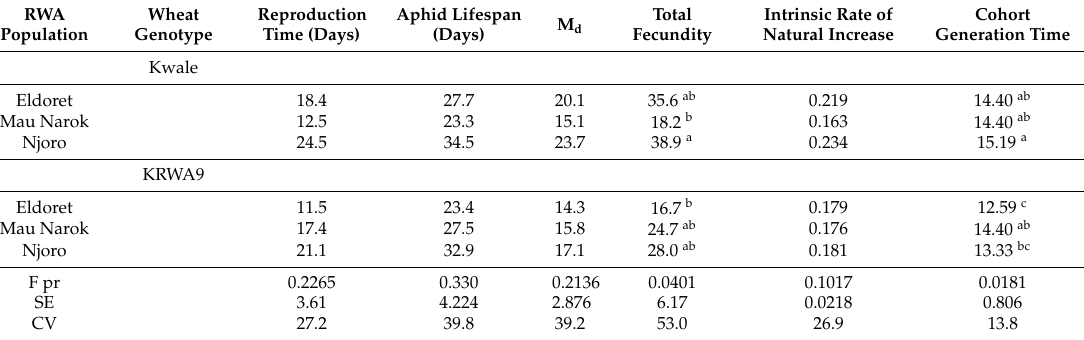
Table 7. Effect of host genotype (Kwale and KRWA9) on the reproduction time (days), total aphid